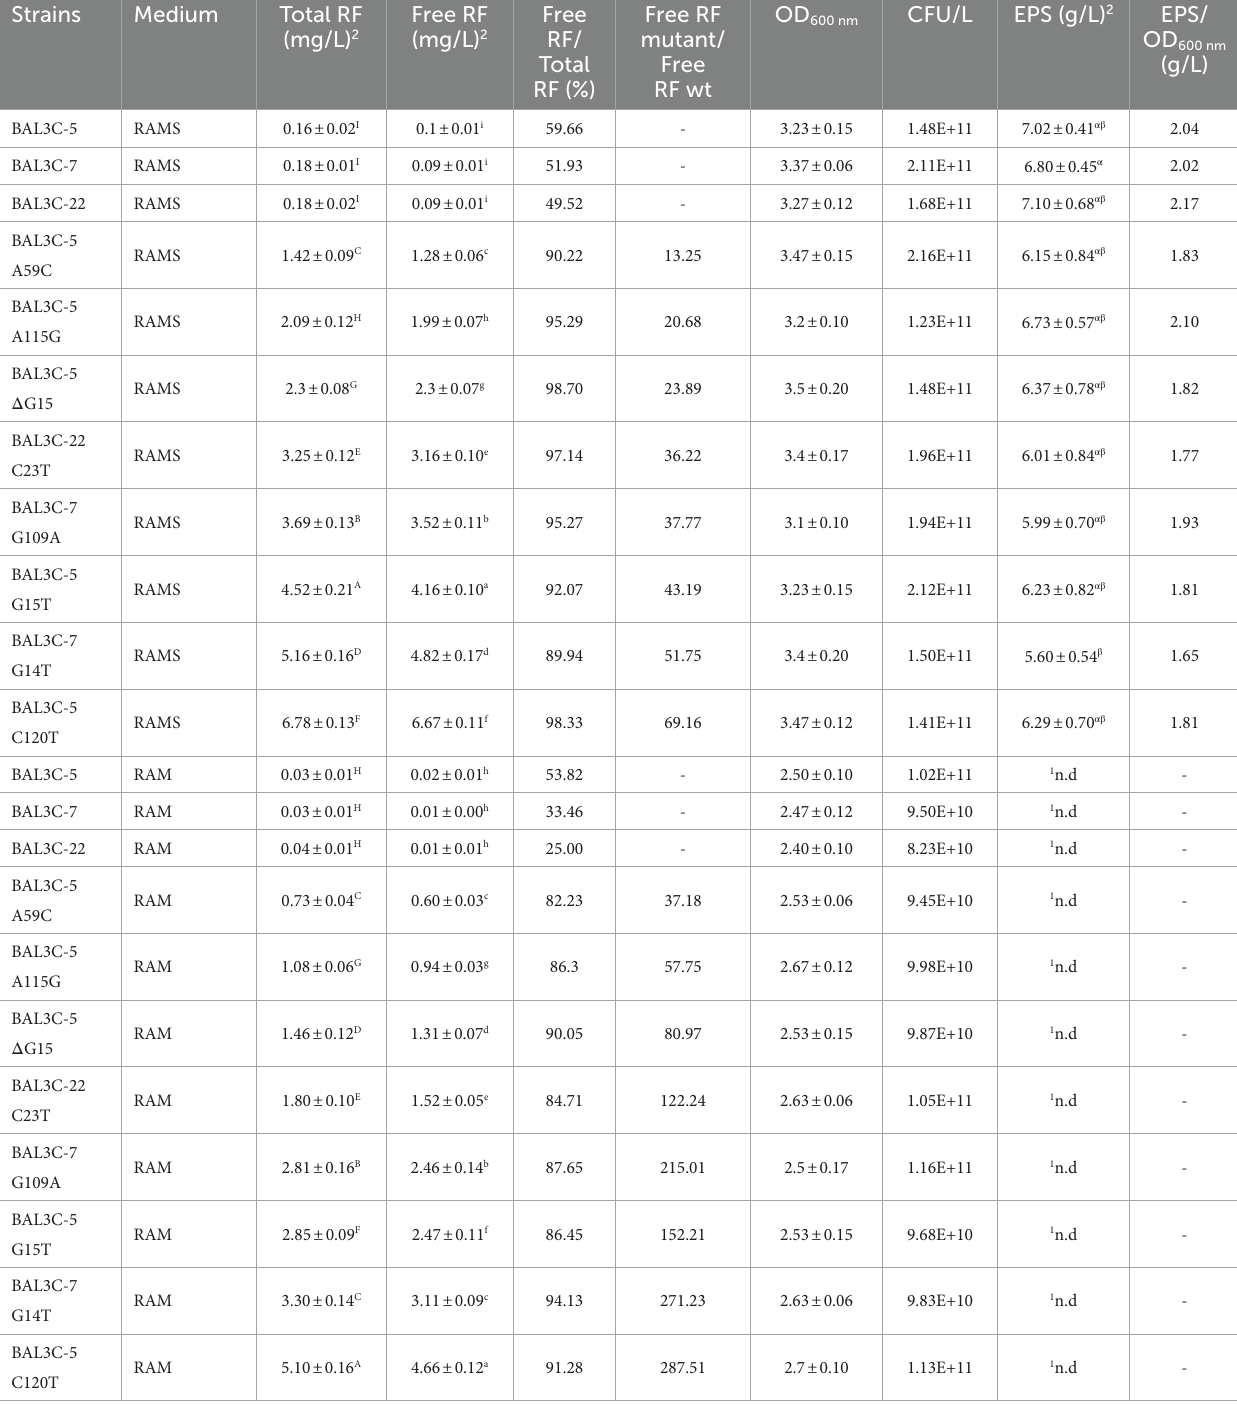
TABLE 3 Analysis of riboflavin and dextran produced by the wt and mutant strains in RAM and RAMS.